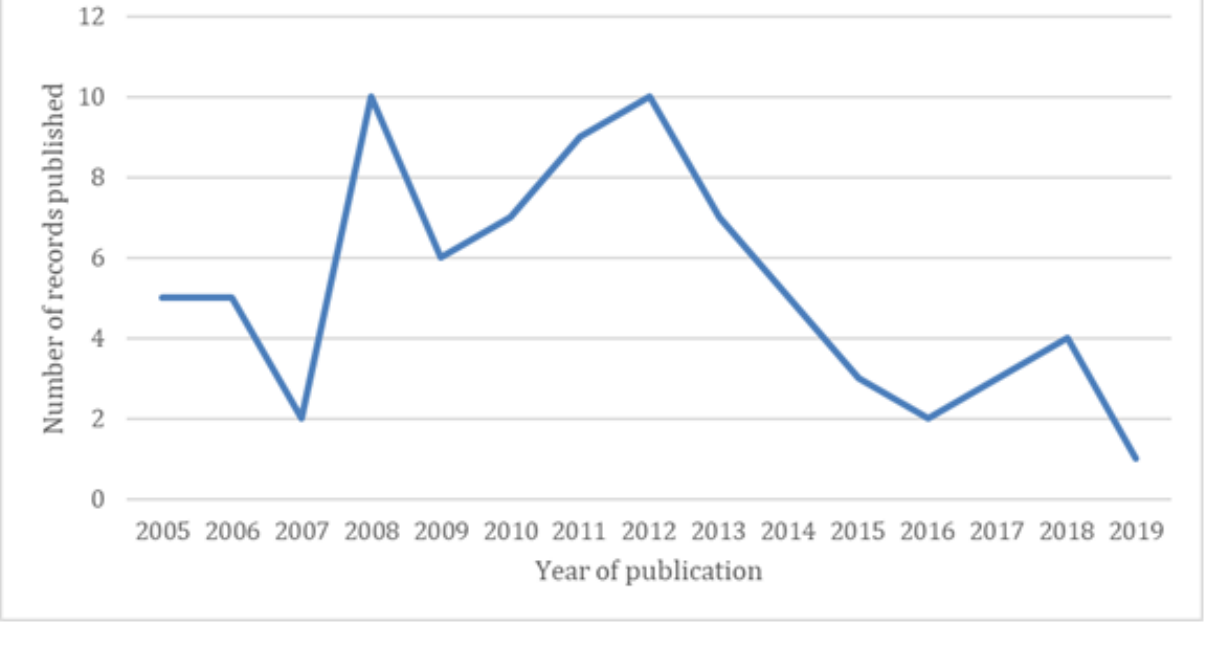
Table 1. Journals and conferences having more than 1 article in the